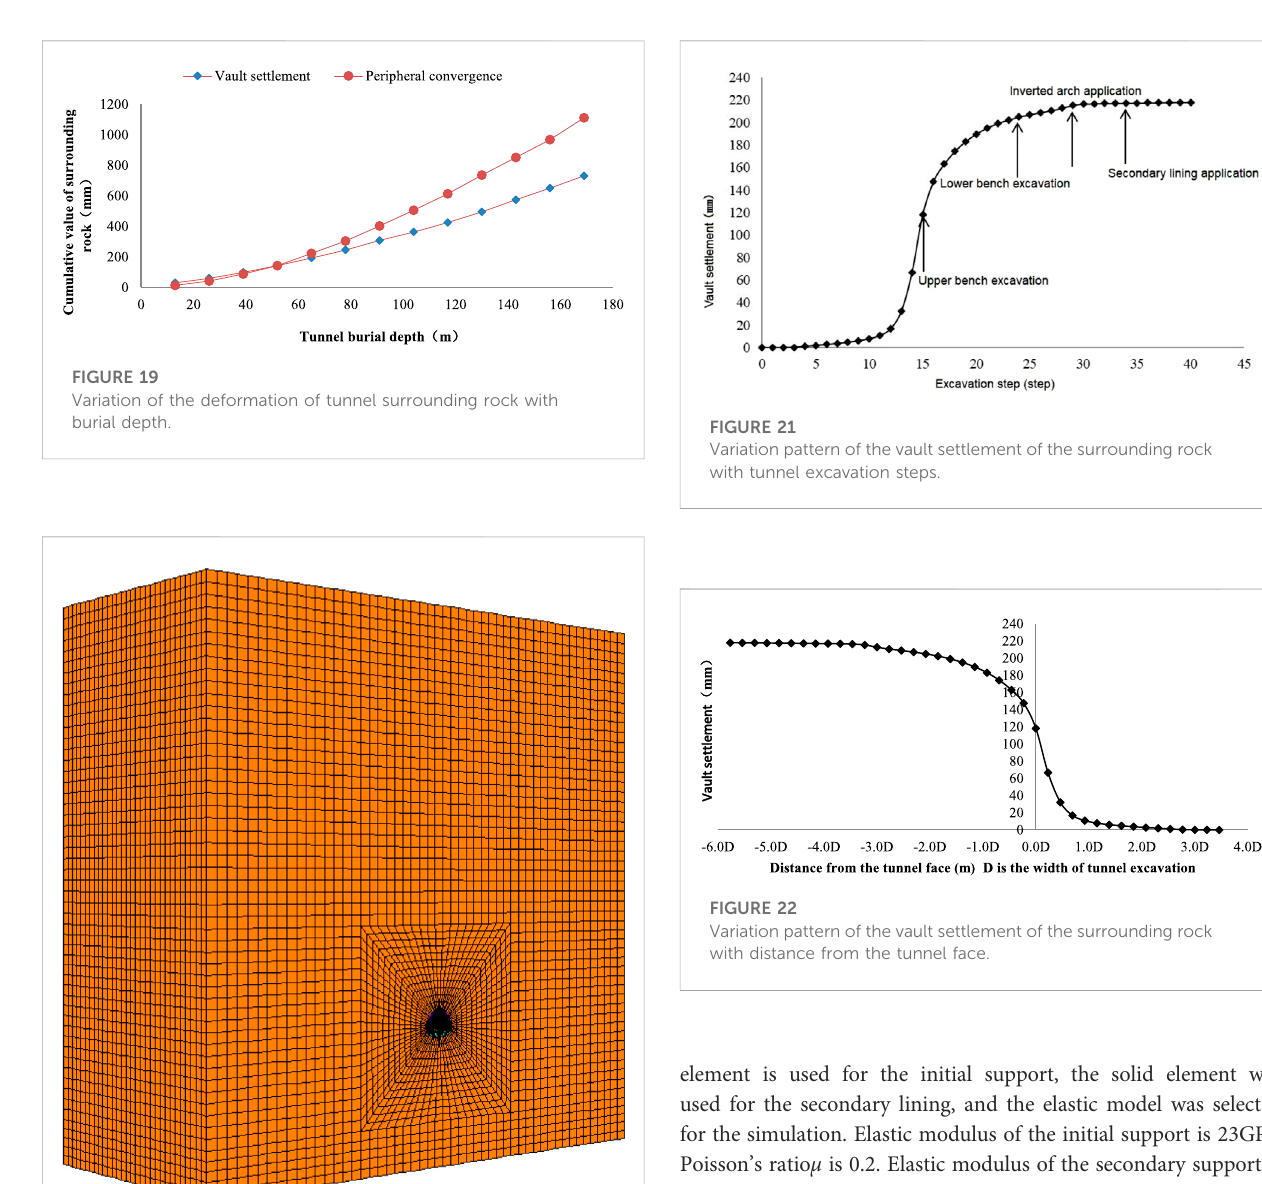
FIGURE 20 Schematic diagram of the overall 3D model.